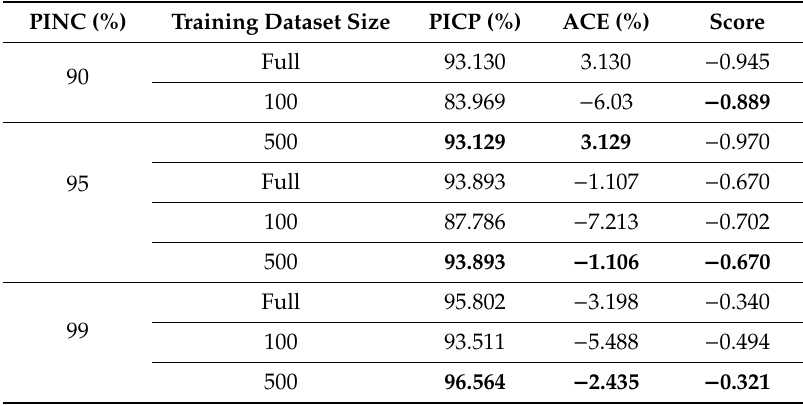
Table 4. Evaluation results of PIs in Y(1)